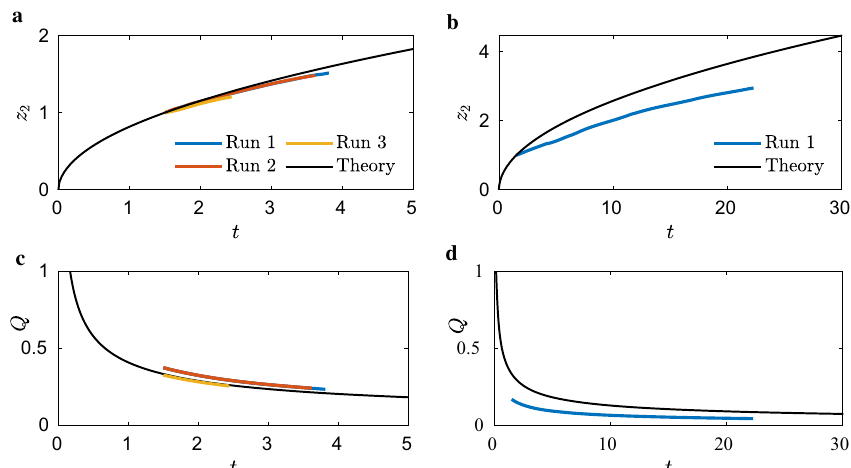
Fig. 6 ICF-2 data. ICF-2 advancing bulk meniscus location z 2 ( t ) and volumetric fl ow rate Q ( t ). a , c small-end drain and b , d large-end drain.